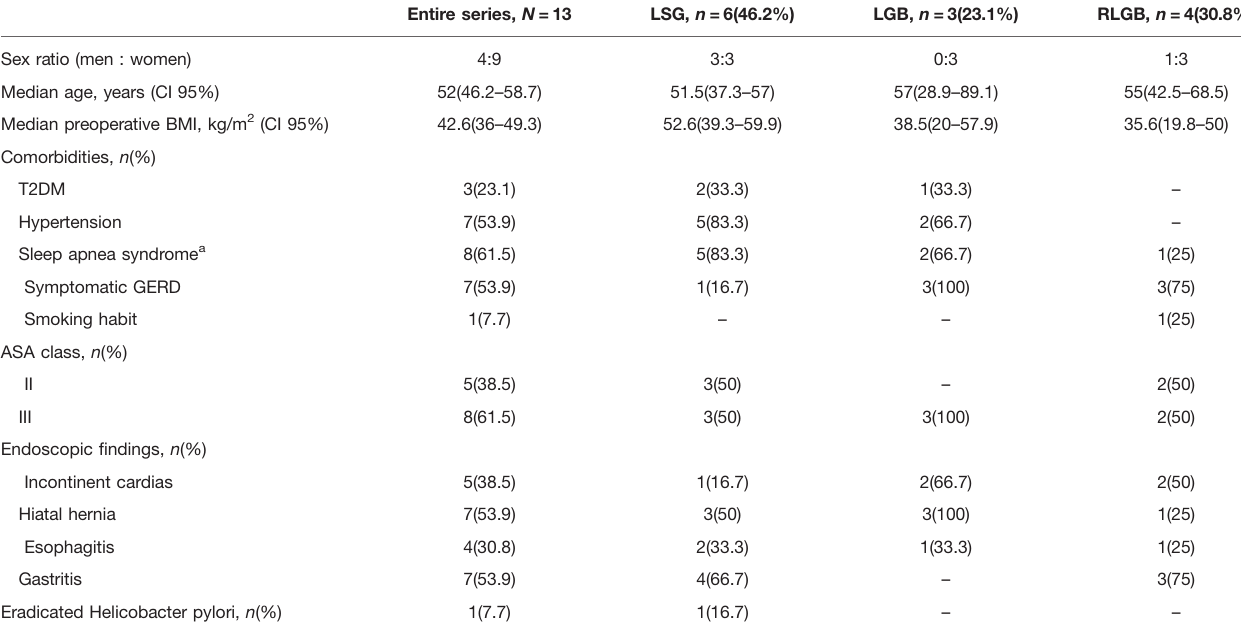
TABLE 1 | Patients ’ characteristics.